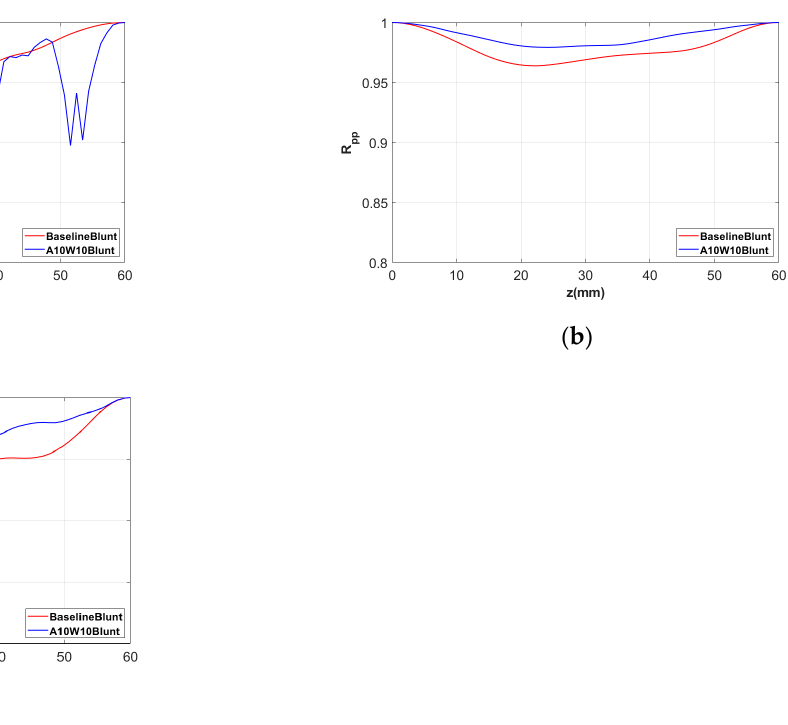
Figure 19. Spanwise correlation analysis of the pressure fluctuations at various streamwise locations: ( a ) x = 0.0 c ; ( b ) x = 0.95 c ; ( c ) x = 0.98 c .